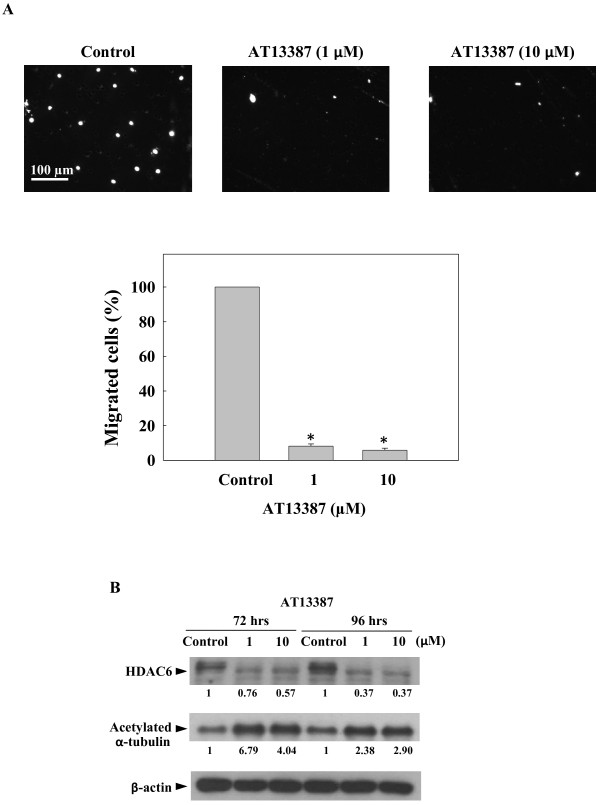
Inhibitory effect of AT13387 on C666-1 cell migration. (A) Trans-well migration assay. The C666-1 cells treated with AT13387 for 72 hrs were harvested and viable cells were seeded on the upper chamber of transwell for migration assay. Upper panel: images of cells migrated through the membrane of migration chamber stained with DAPI. Scale bar = 100 μm. Lower panel: quantification of migrated cells. At least 100 cells were counted from different microscopic fields. Results were expressed as the mean ± S.D. of three separate trials; *p < 0.05. (B) Western-blotting analysis of C666-1 treated with AT13387 for 72 hrs and 96 hrs showed decreased expression of cell migration regulator HDAC6 and increased acetylated form of the α-tubulin. Value represented the arbitrary unit of band intensity after normalization with β-actin.